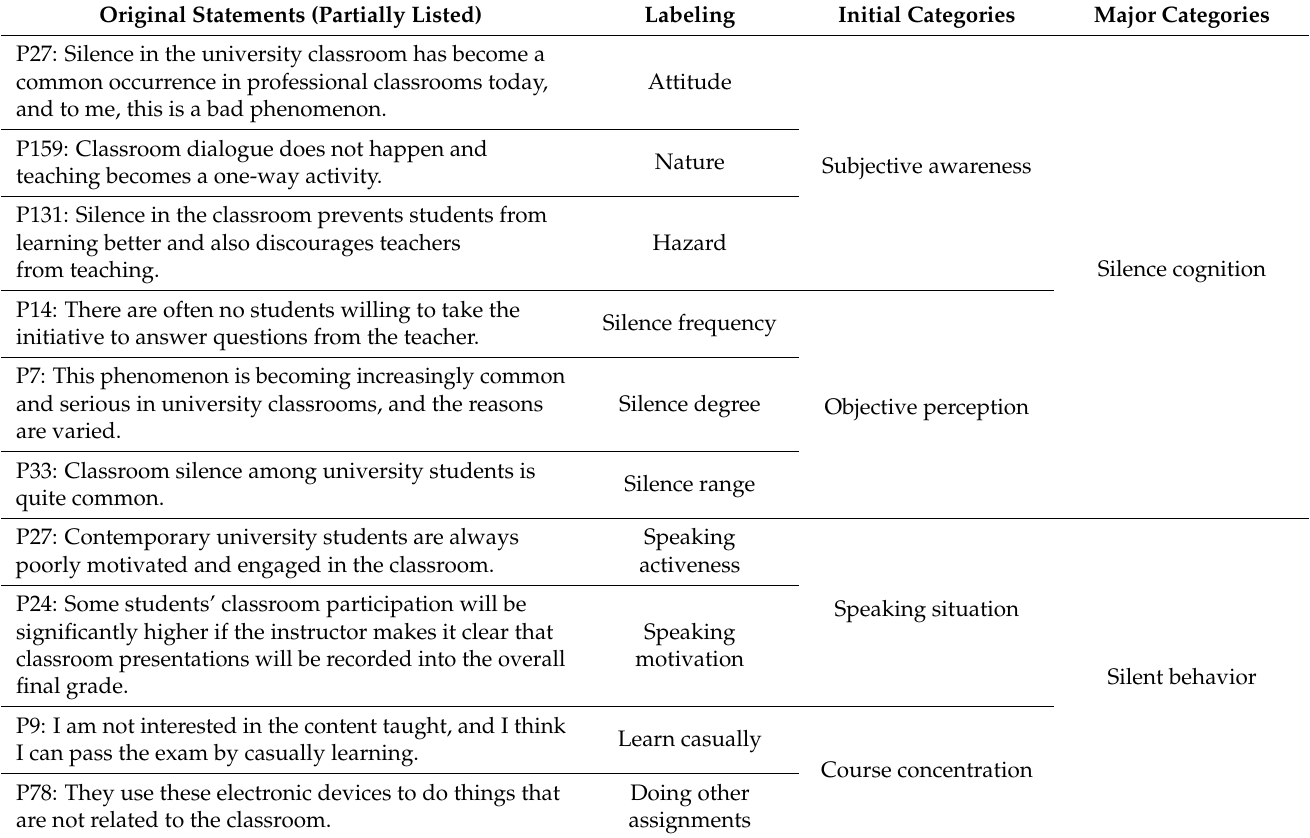
Table 3. Open coding table for professional course silence of Chinese university